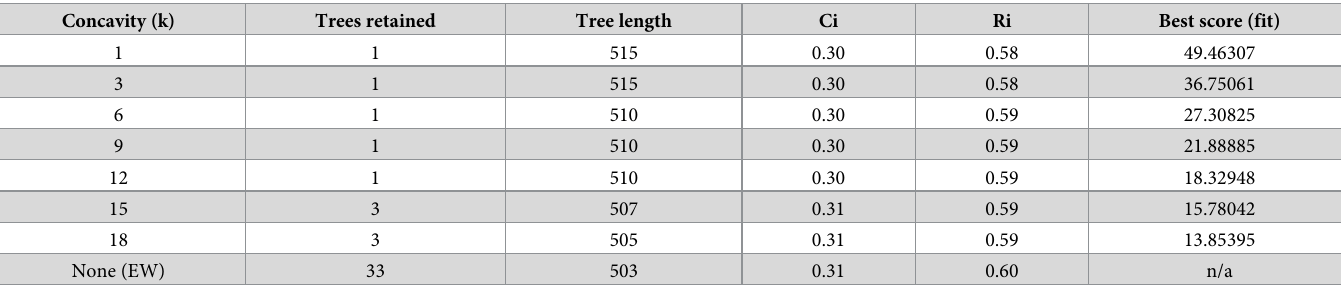
Table 3. Summary results of the eight analyses (k = 1, 3, 6, 8, 12, 15, 18; equal weights) performed on the matrix of S1 Table. Concavity